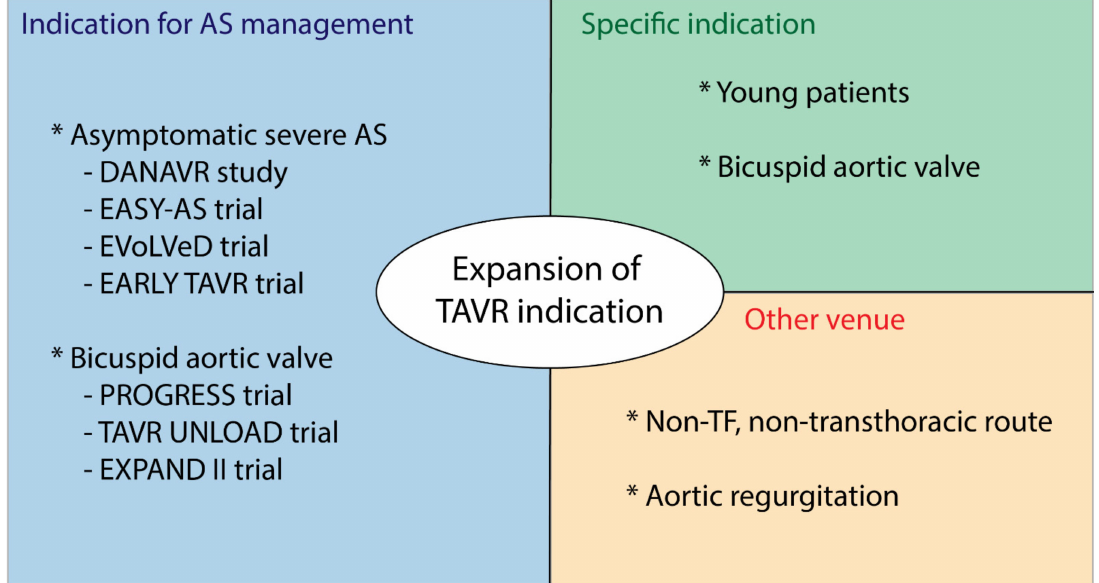
Figure 2. Future direction in TAVR indication; AS, aortic stenosis; TF,